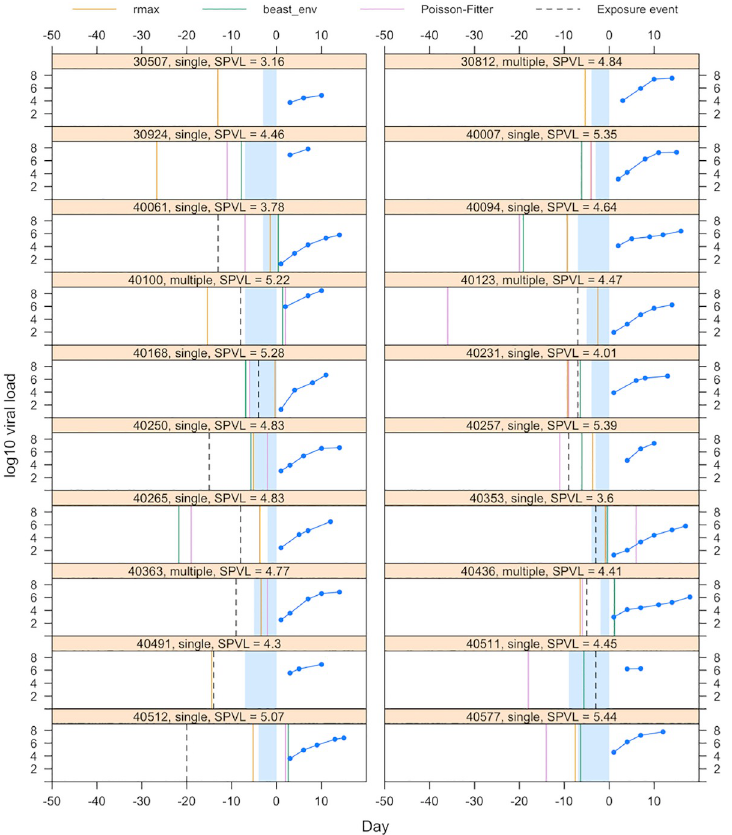
Fig 6. Estimates of the date of infection using three methods for 20 participants (30507 to 40577). The figures show for each individual the viral load measurements in the viral upslope (in blue), the self-reported possible transmission event (dotted black line) and the estimated dates based on molecular dating (in green), Poisson-Fitter (in plum) and viral load growth rates (in yellow). The shaded blue area corresponds to the interval between the last negative and first positive HIV-1 RNA test (or diagnosis date). The bar on top of each graph shows the participant id number along with additional information about whether they were categorized as infections with single or multiple founders, whether their sequences showed insufficient signal for phylogenetic analyses (Lack of Signal, LOS) and whether they became pregnant during this time frame, as well as their set point viral load (SPVL in log10